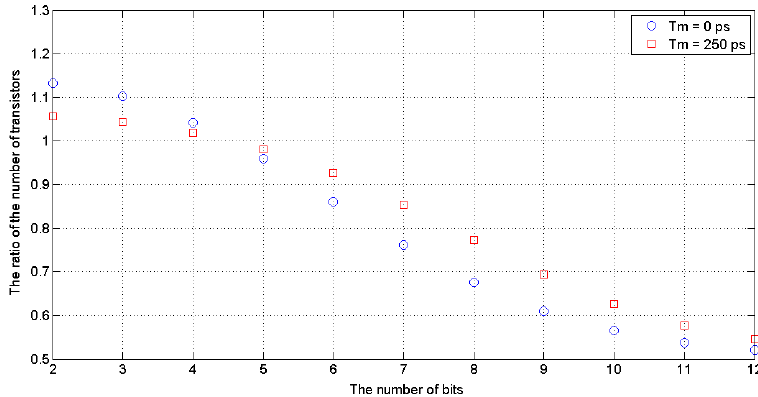
Figure 22. Reduction of SA-TDC complexity obtained by design optimization vs. number of bits.